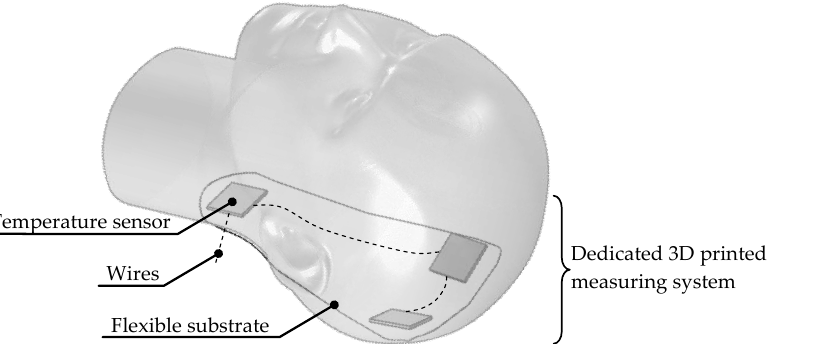
Figure 1. An exemplary application of 3D printed surfaces with planar sensors embedded in a flexible substrate, dedicated to individual needs and purposes.